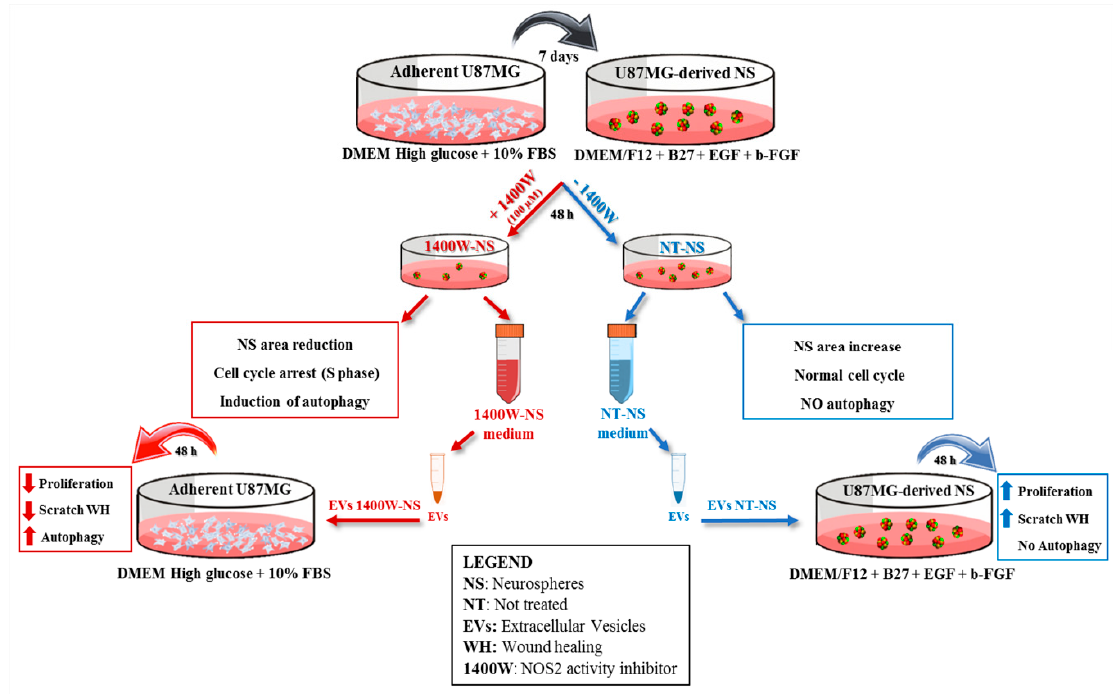
Figure 1. Scheme of experimental design and obtained results.